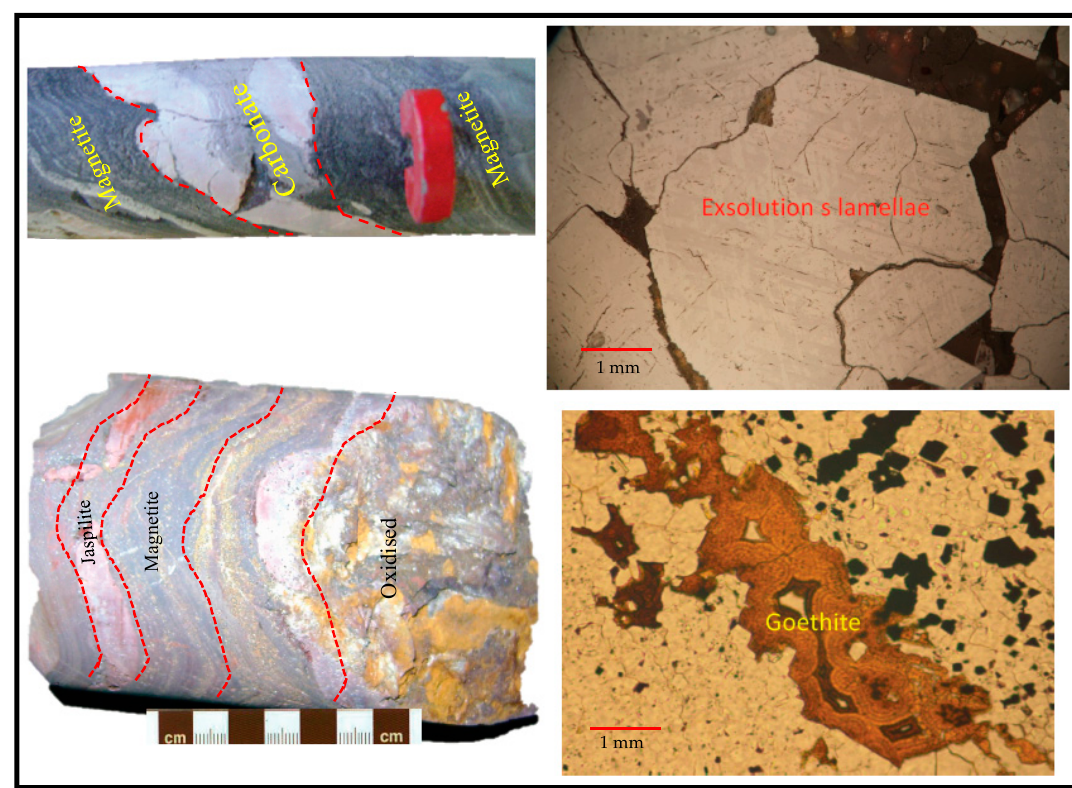
Figure 10. Oxidized brecciated iron formation with goethite and martite. Table 3. Comparison of similarities of Gadarwara with other IOCG